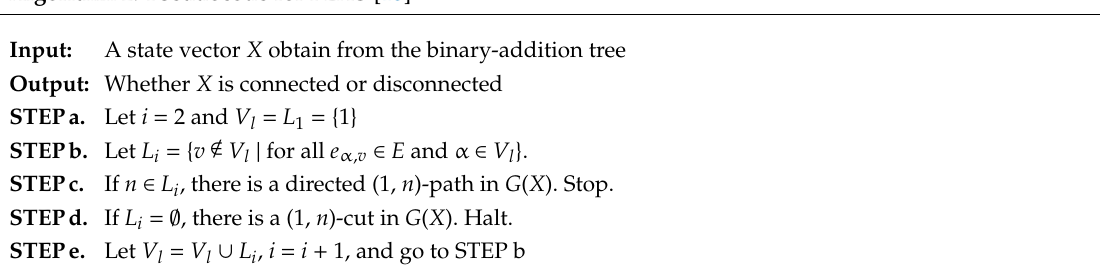
Algorithm 2. Pseudocode for PLAS